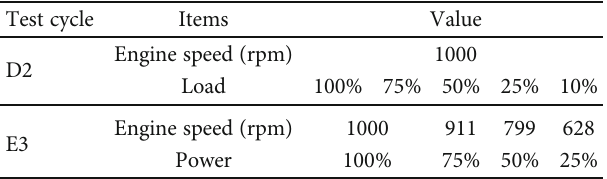
Figure 3: Heat transfer coe ffi cient. Table 5: Test cycle for di ff erent test